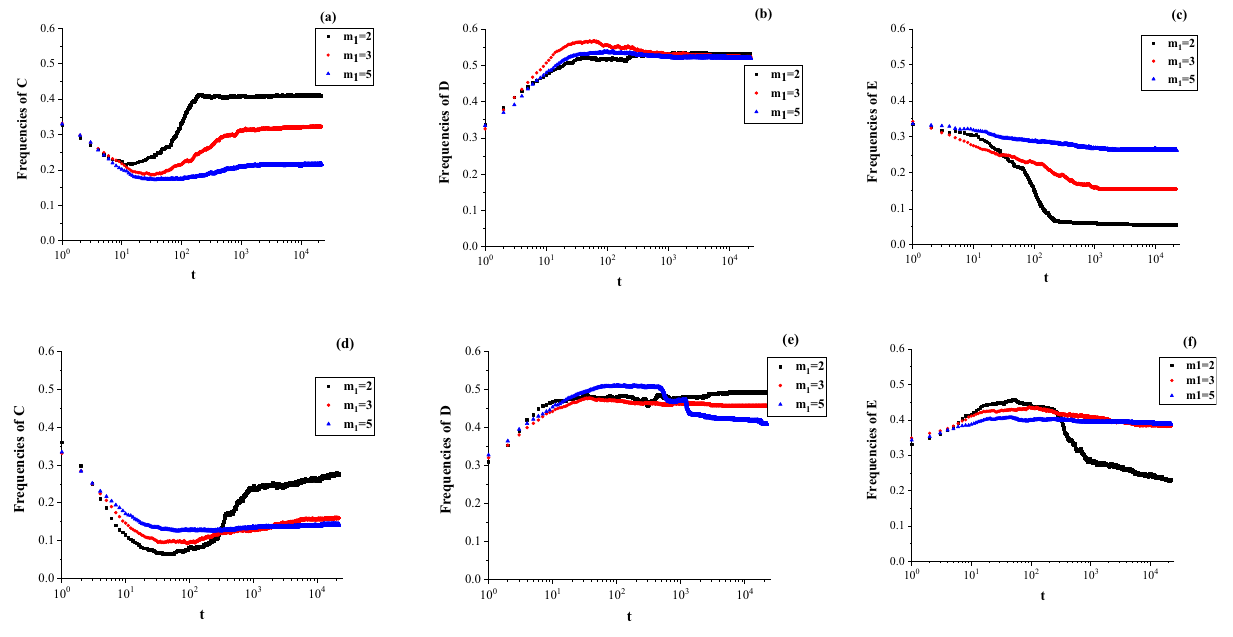
Figure 8. Evolutionary game with different group size m 1 = 2, 3, and 5 : ( a )–( c ) evolution of three strategies for b = 2 and χ = 1.5 ; ( d )–( e ) evolution of three strategies for b = 2 and χ = 3